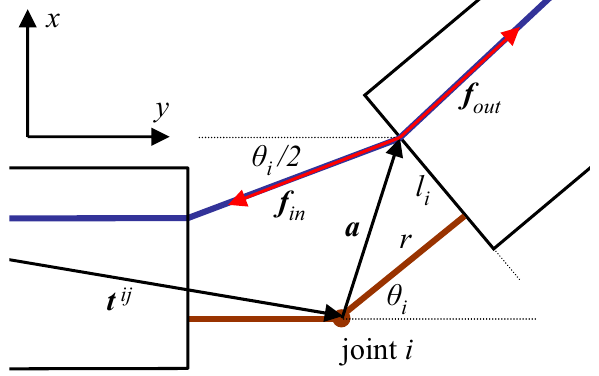
Fig. A1. Torque computation for tendon entry point Figure A1. Torque computation for tendon entry point.